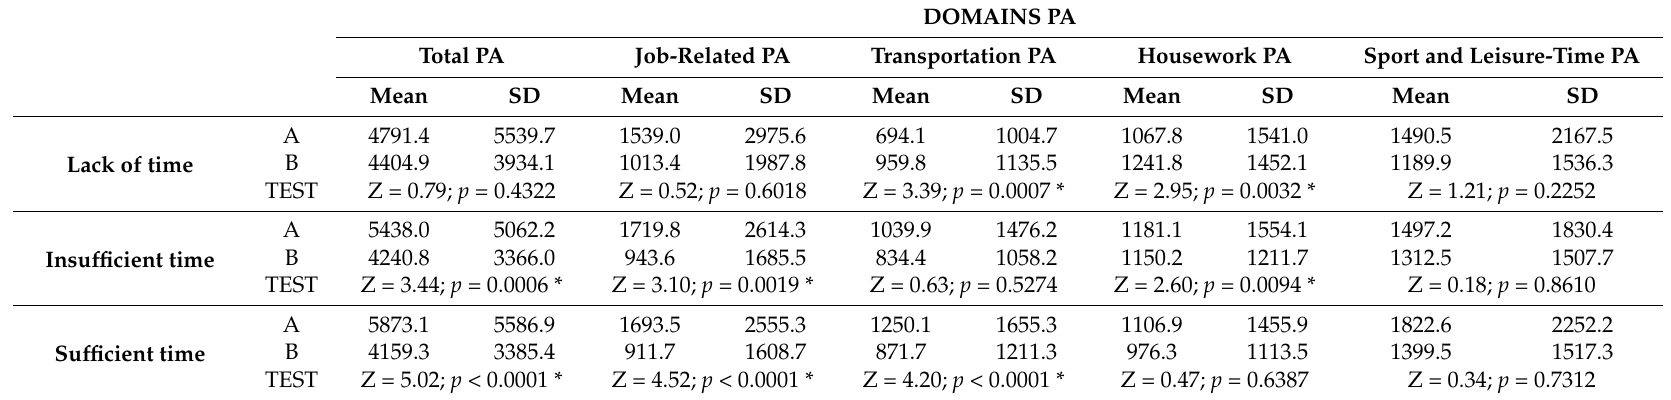
Table 6. Level of total activity and its domains by the amount of available leisure-free in different countries.